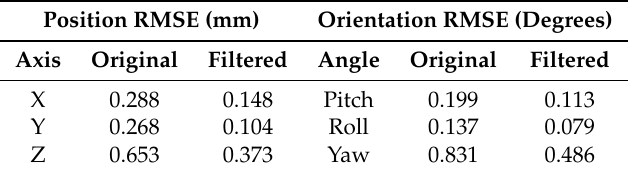
Table 1. Position and orientation Root Mean Square Error (RMSE): Static accuracy